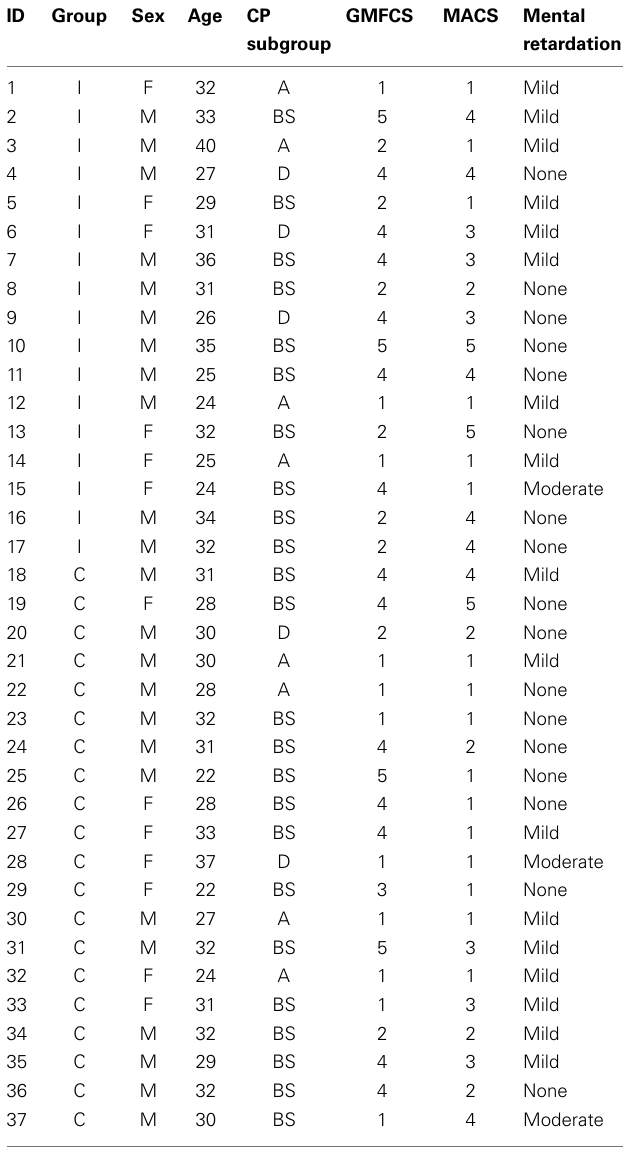
Table 1 | Clinical characteristics of individuals with cerebral